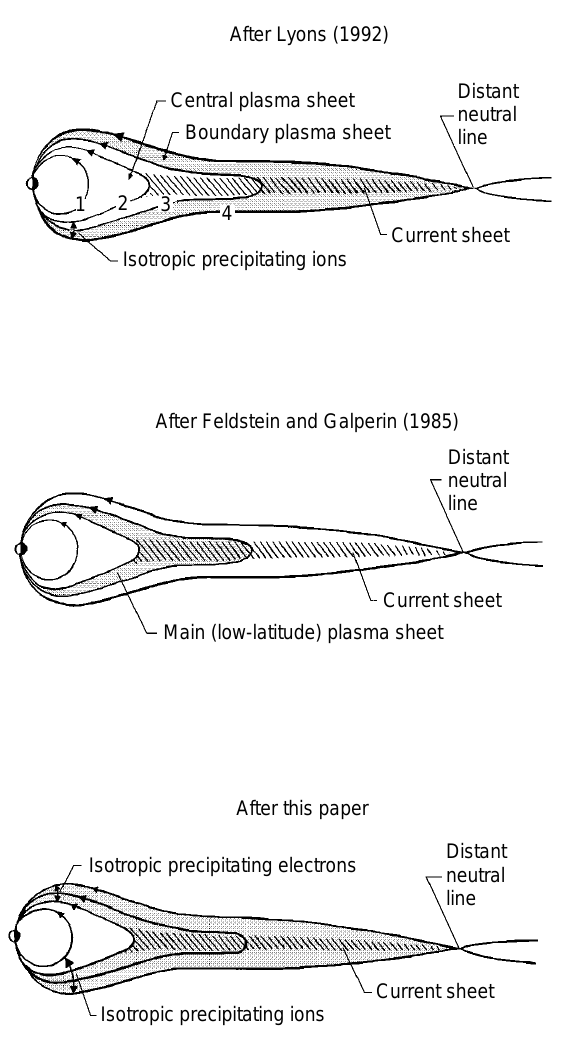
Fig. 4 . Schematic presentation of di(cid:128)erent views to the source region of auroras [adopted from Lyons (1992)]. Each of three panels shows the midnight meridian cross-section of the plasma sheet. Field line 1 is a dipole-like magnetic field line ( B z (cid:136) 30–50 nT at the top of it); tailward of line 2 B z < 5–8 nT (current sheet); line 3 corresponds to inner edge of PSBL, and line 4 marks the outer edge of the plasma sheet. The upper panel reproduces the view advocated by Lyons and co-workers, the middle panel represents the view of Feldstein and Galperin, and in the bottom the result of this study is presented. The hatched region means the current sheet; the dotted area on each panel shows the region of discrete auroras according to the views of